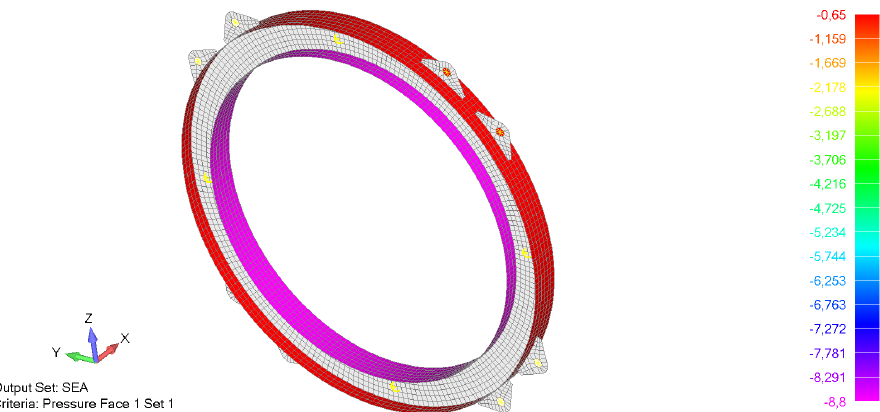
Figure 4. Loads on the transverse ring (pressure in MPa).